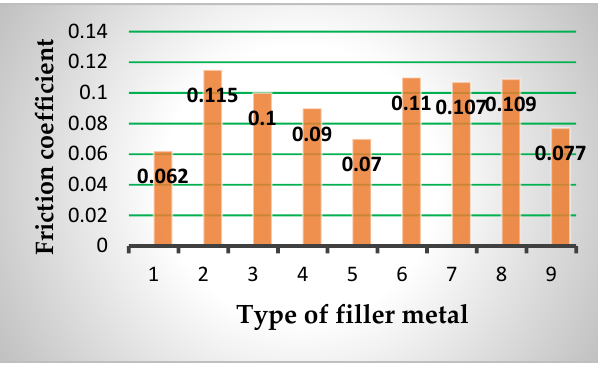
Figure 17. Comparison of the average values of the friction coefficient for various filler metals (Numbers correspond to notation of Table 7).